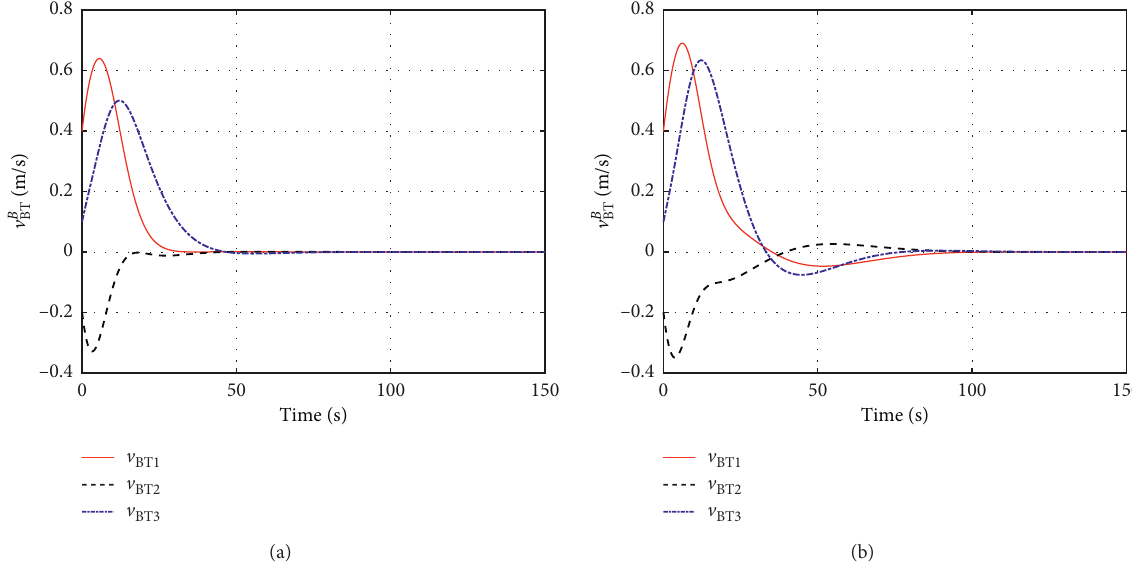
Figure 5: Relative linear velocity. (a) Proposed I&I adaptive controller. (b) CE-based adaptive controller.